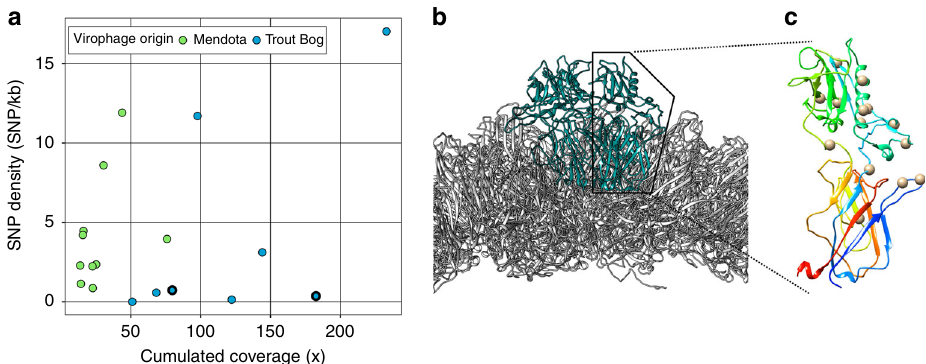
Fig. 3 SNPs density of virophage genomes ( a ) and location of non-syonymous SNPs on Mendota_1002202 minor capsid protein ( b , c ). a Virophages are colored according to the lake where they were identi fi ed. The two virophage genomes encoding divergent family B DNA polymerase genes are highlighted with a bold outline. b Subset of the sputnik virion model (3J26), with major and minor capsid proteins depicted in gray and blue, respectively. The model is oriented so that the bottom of the picture correspond to the inside of the virion, and the top to the outside. c The structure of a single minor capsid protein unit (from the same sputnik model 3J26), is colored by N to C orientation (from blue N-terminal to red C-terminal). The location of non-synonymous SNPs observed in Mendota_1002202 are indicated with gray